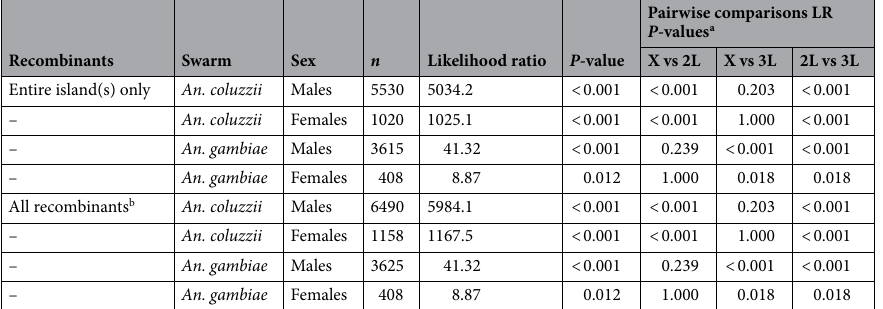
Pairwise comparisons LR P -values a X vs 2L X vs 3L 2L vs